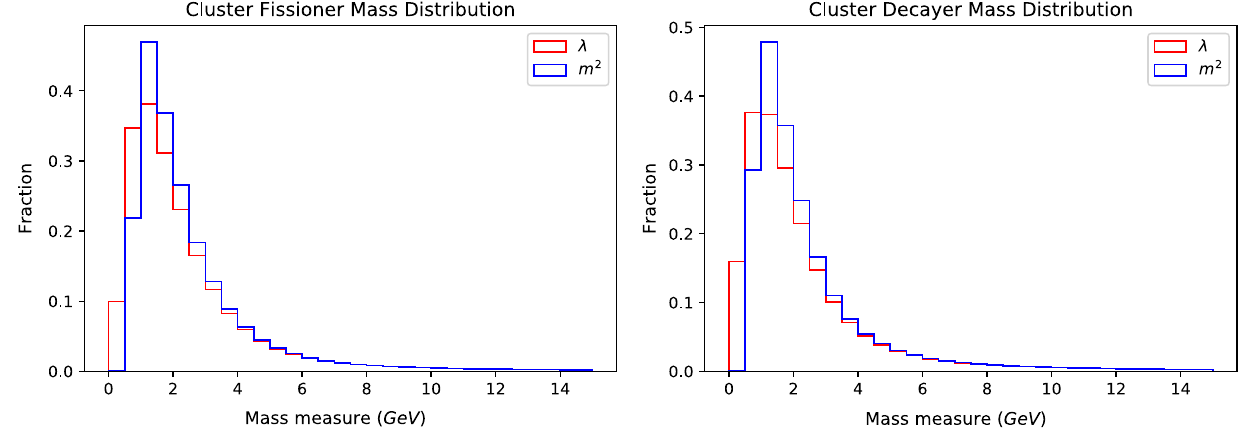
Fig. 9 Comparison of the two different mass measures for the cluster fission and cluster decayer stages respectively for LHC Minimum Bias events at 7 TeV